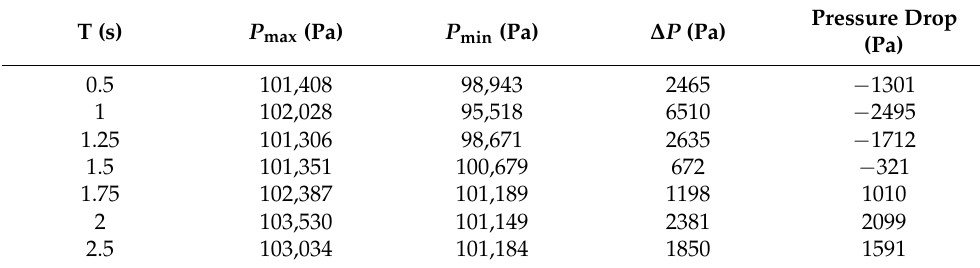
Figure 12. The pressure distributions of the fluid field of the OSAHS patient’s upper airway under the state of eupnea (pressure unit in Pa). ( a , b ) The inspiration phase; ( c , d ) the expiration phase. Table 1. The change of the cavity pressure of the OSAHS patient under